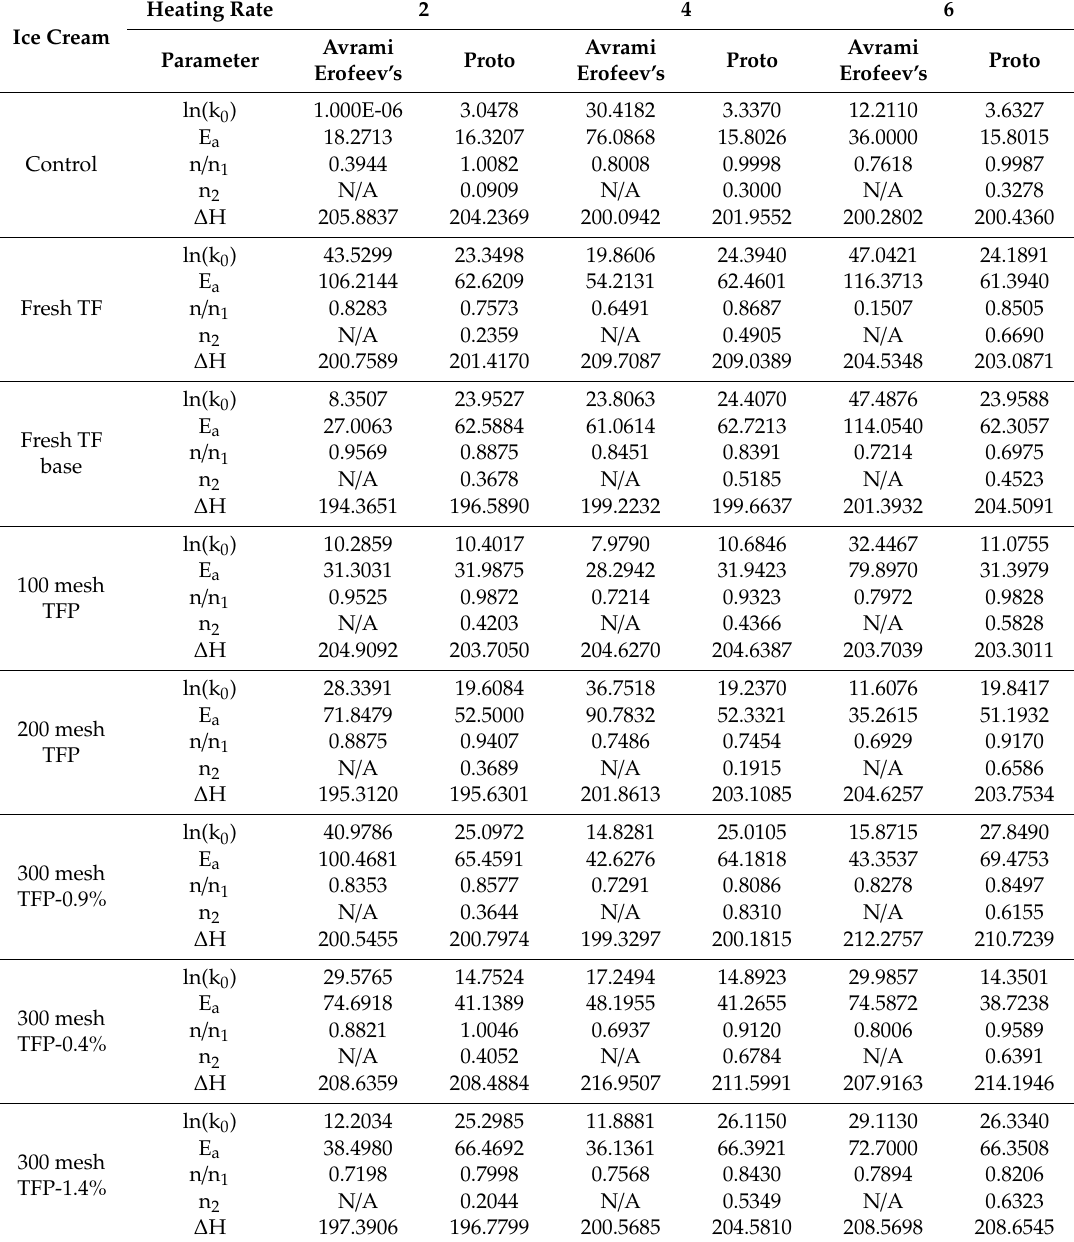
Table 4. Melting kinetic simulation results of DSC analyses for T. fuciformis ice creams from − 60 to 30 ◦ C at heating rates of 2, 4, and 6 ◦ C /